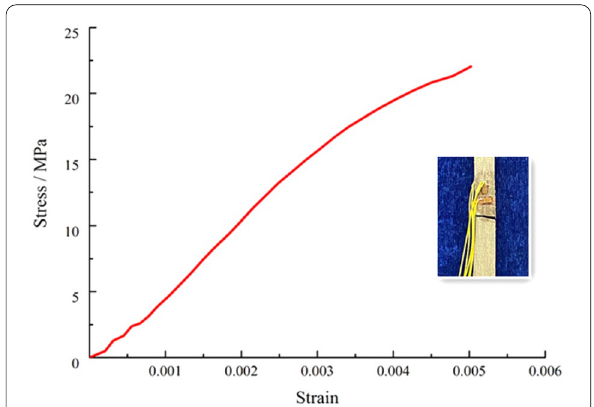
Fig. 1 Stress–strain relationship of the WPC